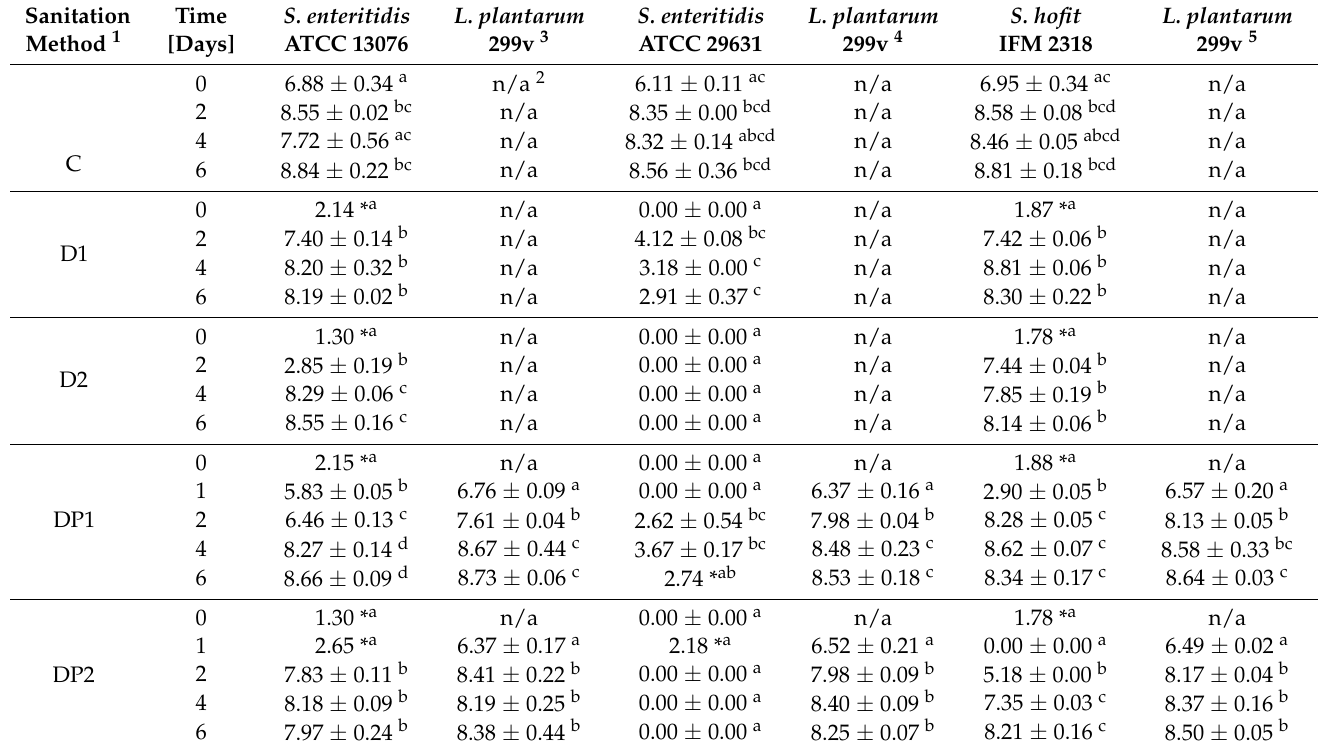
Table 2. The average number of Salmonella and Lactobacillus plantarum 299v on mung beans seeds sanitised by different methods and sprouted [log CFU g − 1